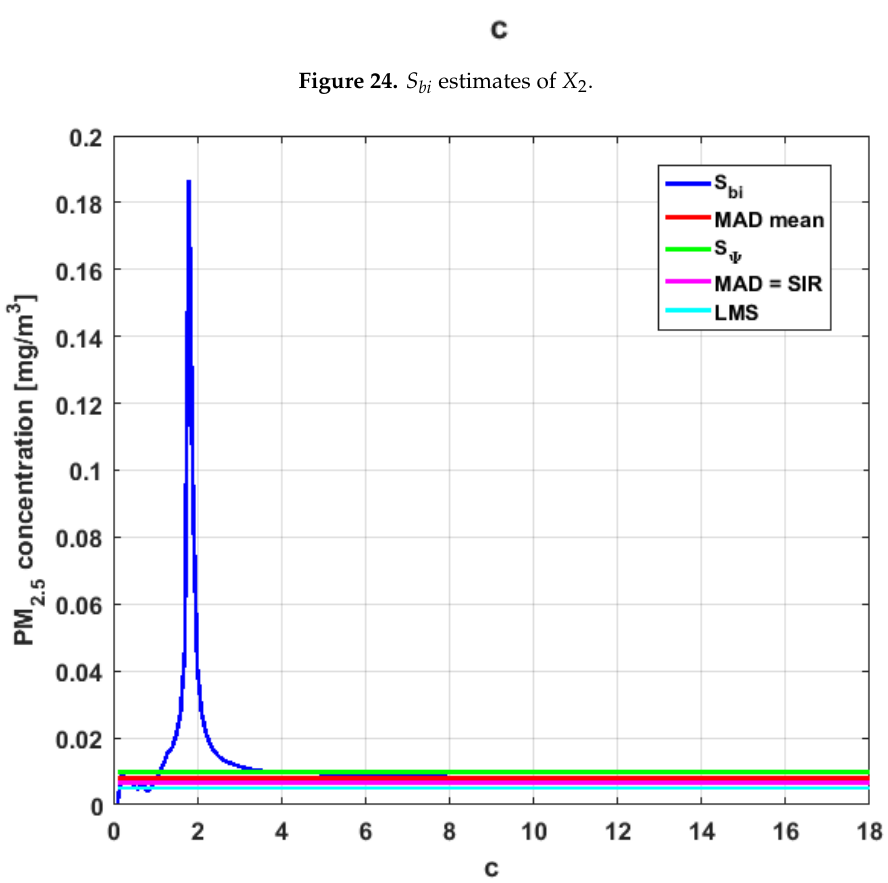
Figure 25. S bi estimates of X 3 Figure 25. 𝑆 𝑏𝑖 estimates of 𝑋 3 . Figure 25. 𝑆 𝑏𝑖 estimates of 𝑋 3 .